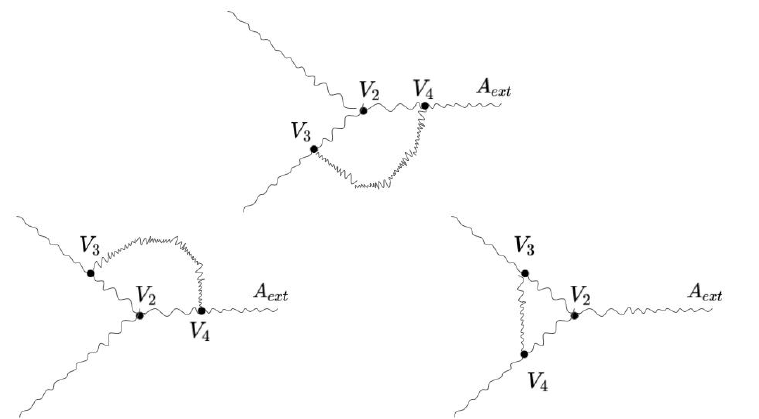
Figure 12: Three possible higher loop corrections. In addition to the already existed vertices V , V , V that were used in the computation in the previous subsections, 0 1 2 it contains two extra vertices V , V , and three extra propagators P 3 4 distinguish the internal propagators and the external leg, by showing A on the external